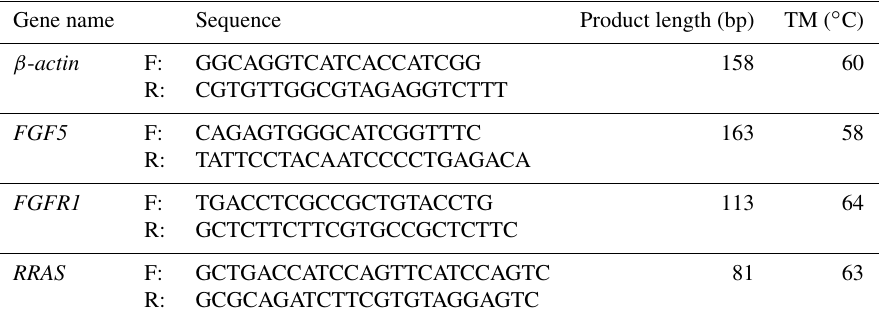
Table 3. Primer sequence in